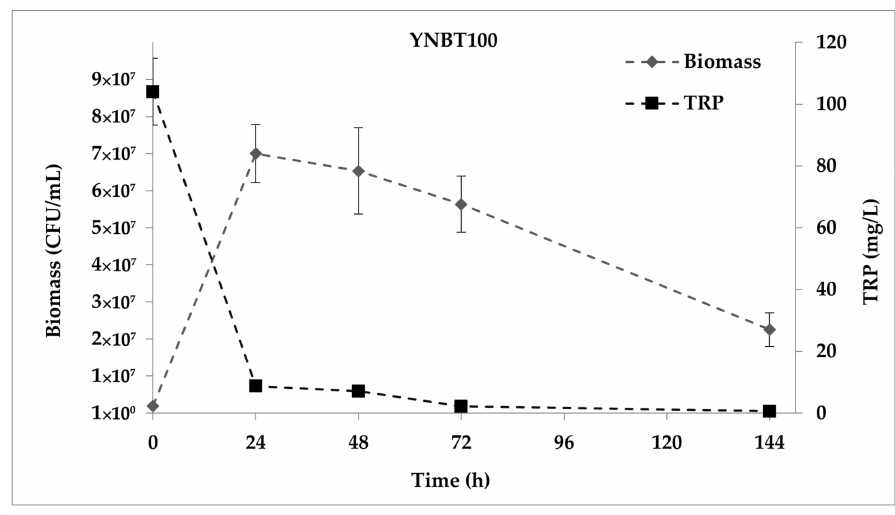
Figure 1. S. cerevisiae EC1118 growth curve in YNBT100 medium and TRP consumption. The KYN pathway is an important metabolic pathway in which TRP is converted to compounds with different biological functions along three different branches (Figure 2a). The KYN route of the TRP degradation was followed throughout the kinetics production of TRP, KYN, 3OH KYN, KYNA, AA, and 3OH AA (Figure 2b).